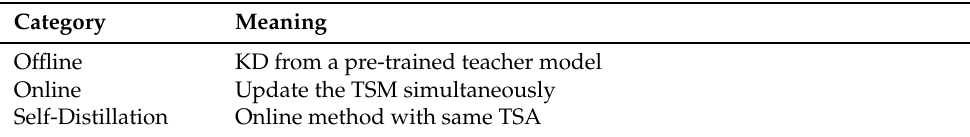
Table 3. KD Classification according to Distillation Type.